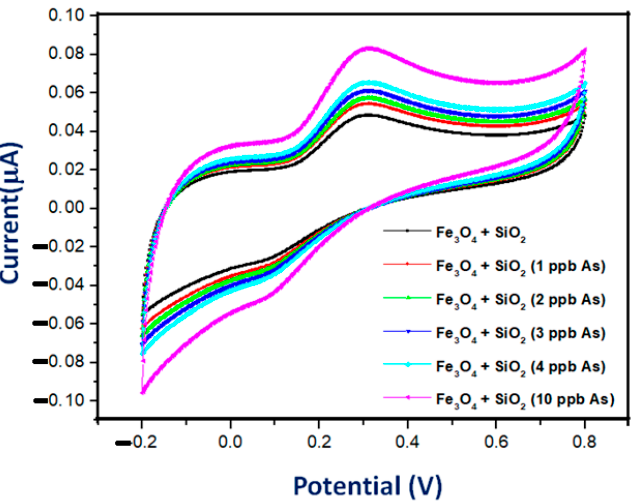
Figure 6. Cyclic voltammetric response of bare Fe 3 O 4 @SiO 2 MNPs, and Fe 3 O 4 @SiO 2 MNPs with varying Arsenic concentrations from 1–10 ppb .